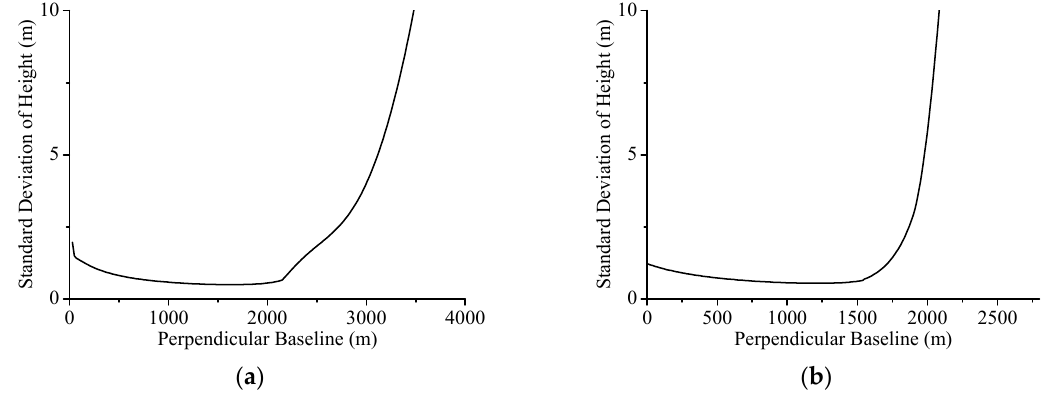
Figure 12. Standard deviation of height versus the perpendicular baseline. ( a ) Corresponds to the Figure 11(a) data set; and ( b ) corresponds to the Figure 11(b) data set. For the abovementioned complex terrains, the optimal baselines are 1632 m and 1214 m.